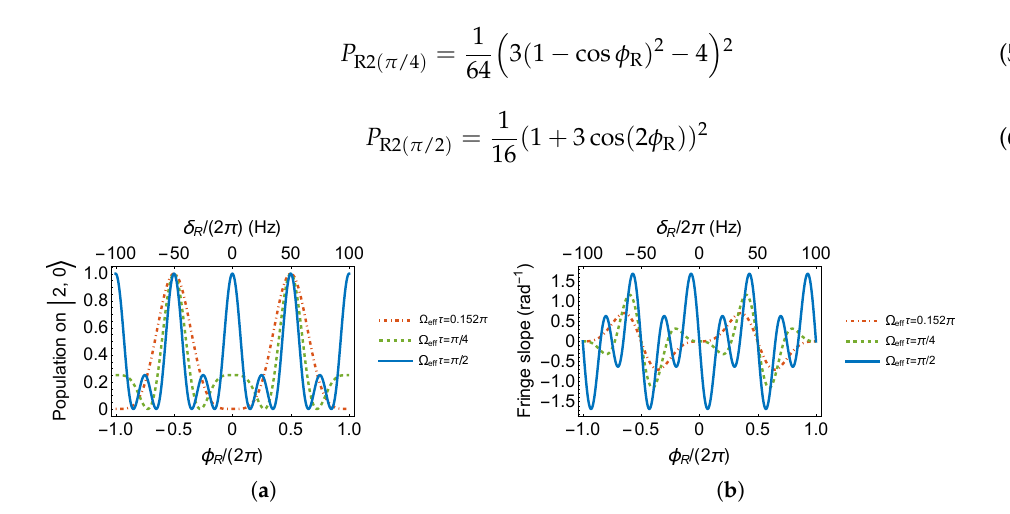
Figure 5. ( a ) Ramsey fringes and ( b ) its slopes on | 2,0 (cid:105) . The fringe slopes in Figures 4b and 5b are, respectively, 0.66, 1.00, 0.70, 1.17, 1.67 rad − 1 . We conclude that if 87 Rb 5 2 S 1/2 is chosen to measure the magnetic field by the RF Ramsey method, conditions such as the initial state prepared on | 2, 0 (cid:105) , observation on | 2, 0 (cid:105) and pulse area of π /2 yield the highest fringe slope, resulting in the most sensitive measurement. The fringes are periodic with the interferometer phase φ R . To determine the fringe center, where φ R = 0, one can vary the free evolution time T in the Ramsey sequence. The fringe center is overlapped independent of evolution time T in Figure 6a. Although the fringes in a multi-wave interferometer are complicated, near the regime of the highest fringe slope, the change in the readout probability is linear to the change in the interferometer phase, as demonstrated in Figure 6b.